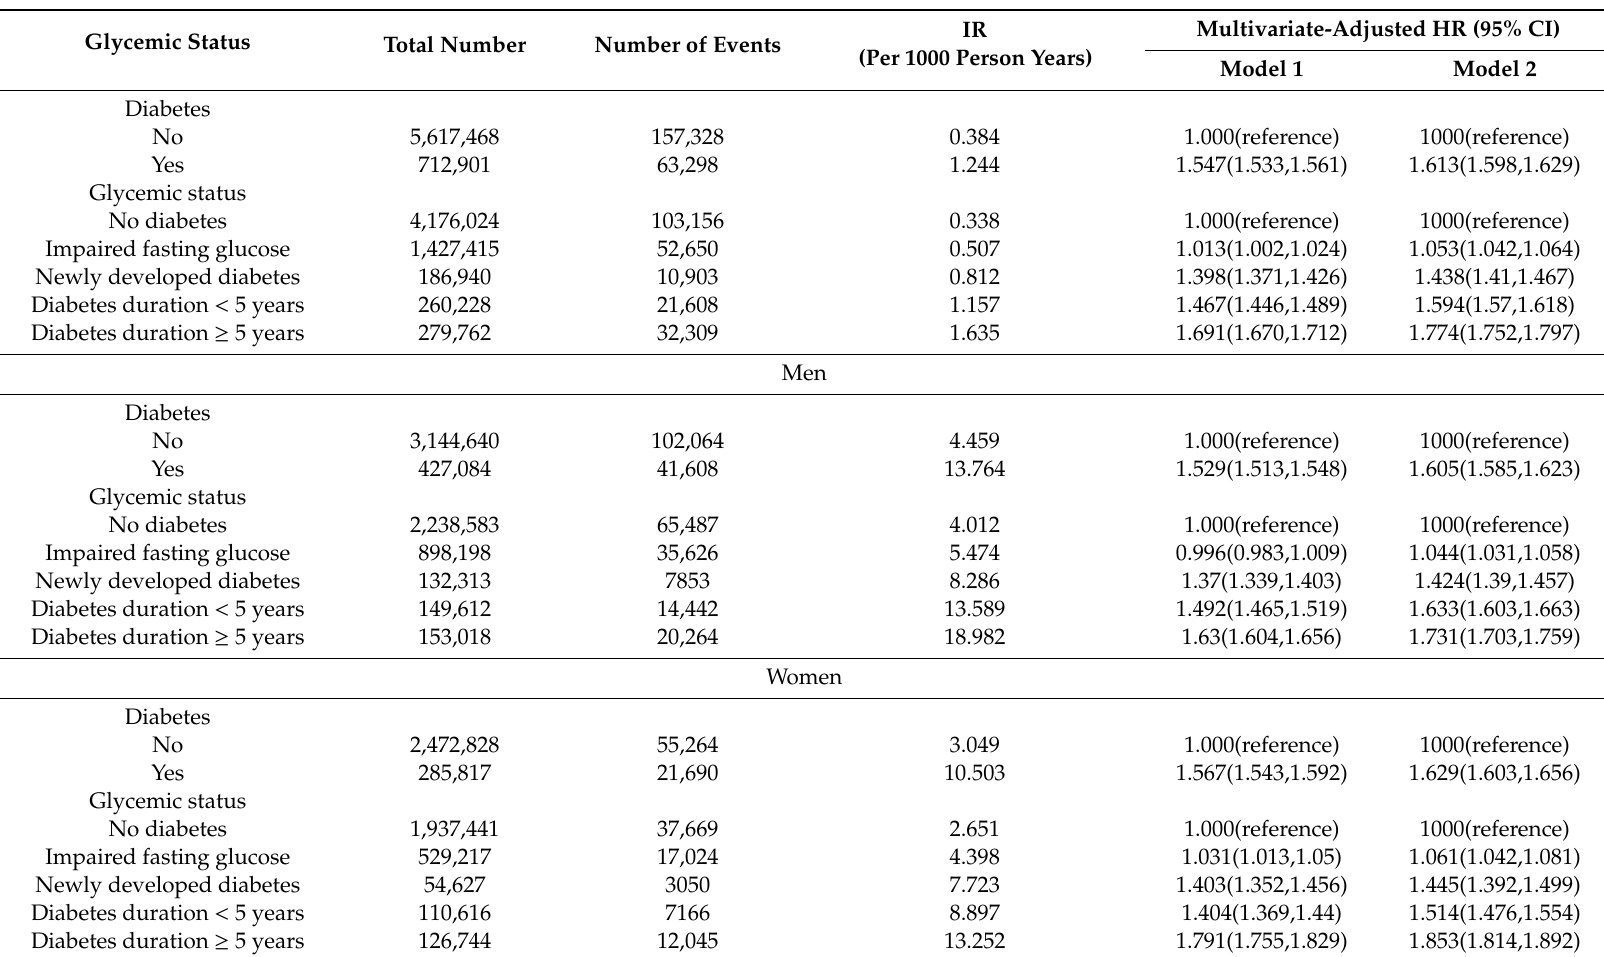
Table 2. IR and multivariate-adjusted HR of mortality according to baseline glycemic status and diabetes